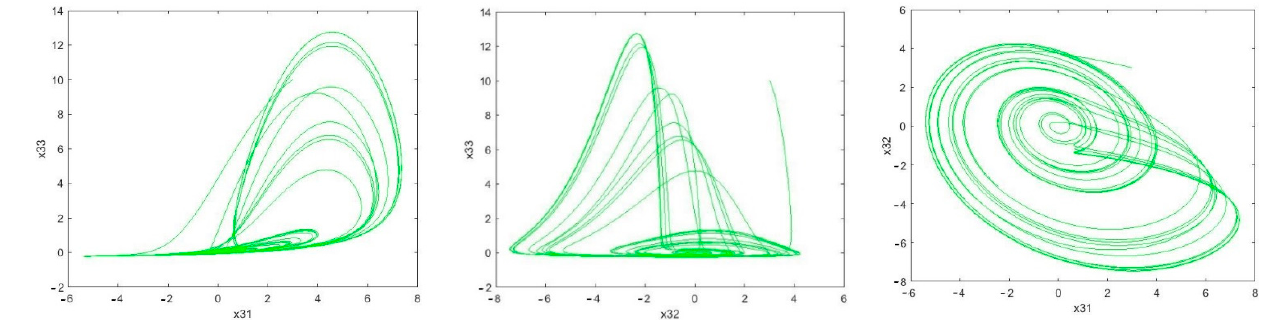
Figure 7. Sample phase curves of the first slave system.